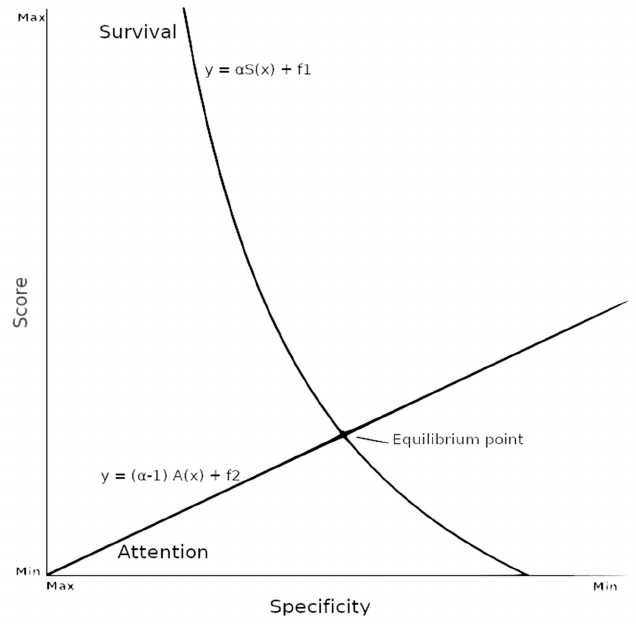
Figure 1. Graphical representation of an equilibrium point.